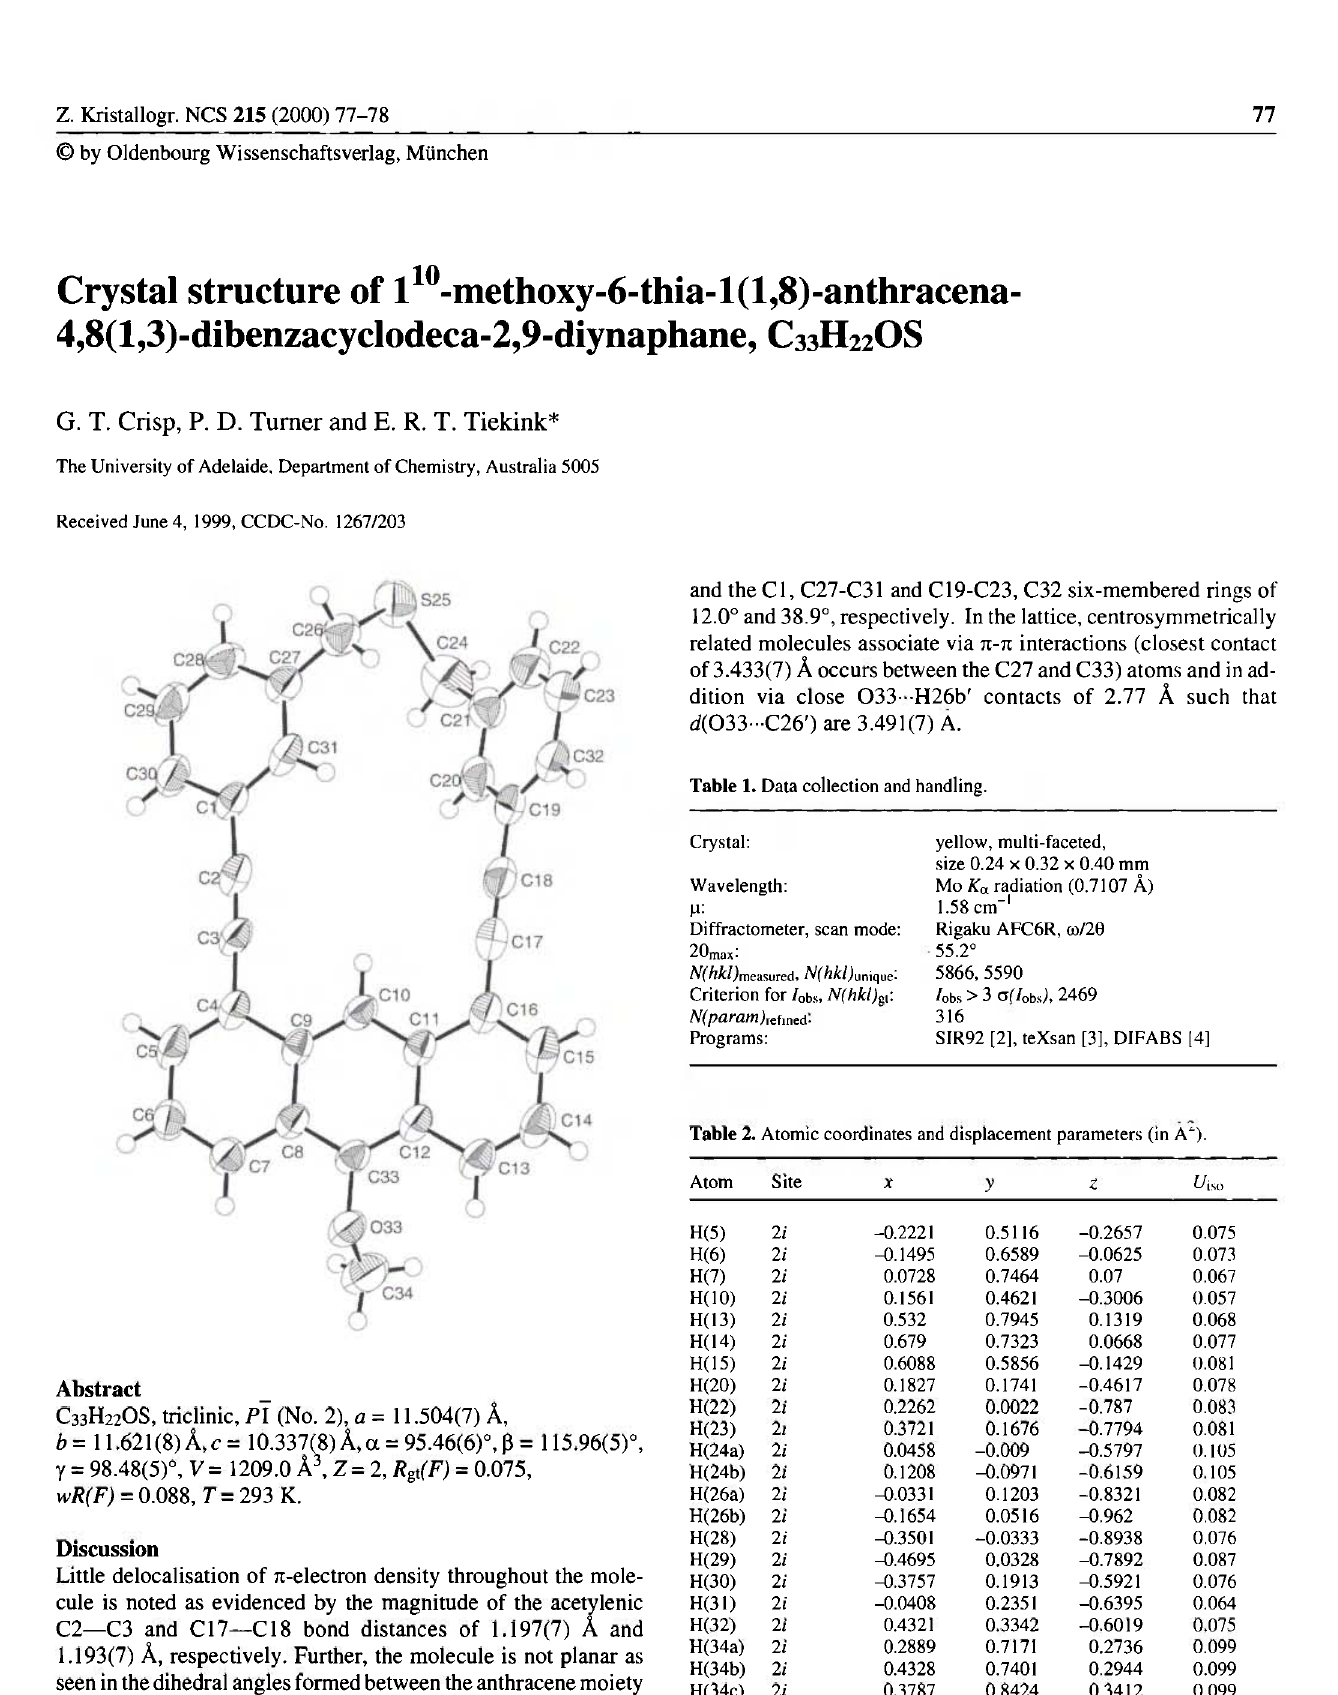
Table 2. Atomic coordinates and displacement parameters (in A